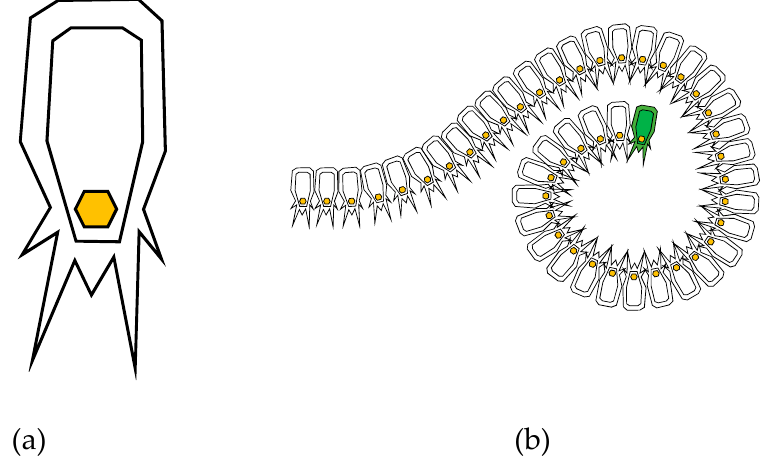
Figure 2. ( a ) Individual salp and ( b ) swarm of salps (chain).